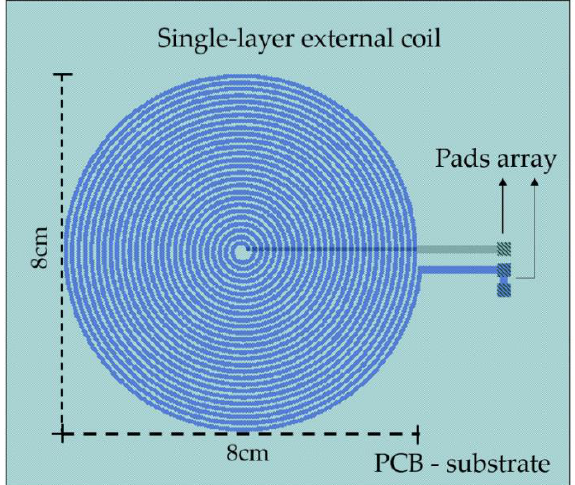
Figure 5. External coil design features.